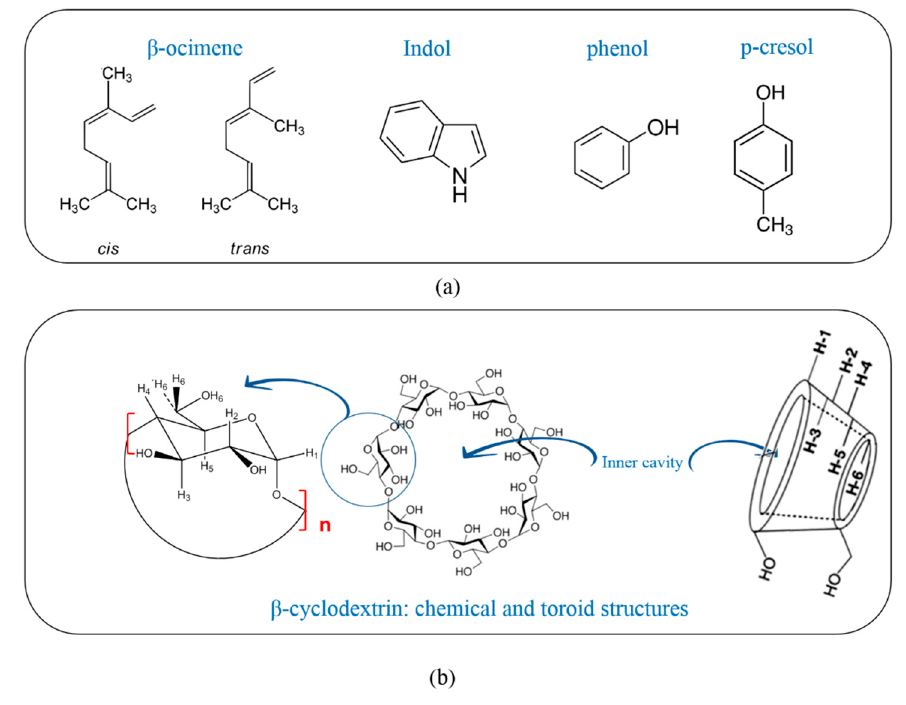
Figure 1. ( a ) Guest molecules structure: cis and trans β -ocimene, indole, phenol and p-cresol. ( b ) CD chemical and toroid structures, n = 7.